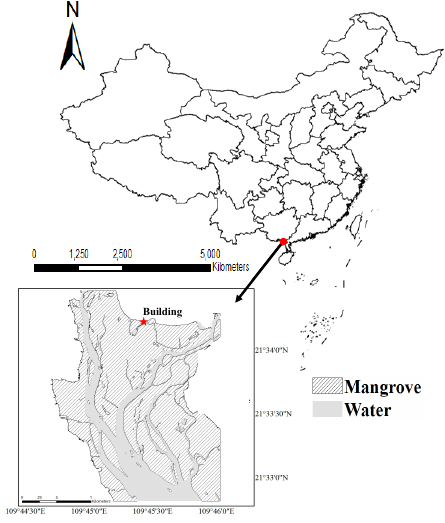
Figure 1. Location of the Gaoqiao Mangrove Reserve measurement site and the building where measurements were